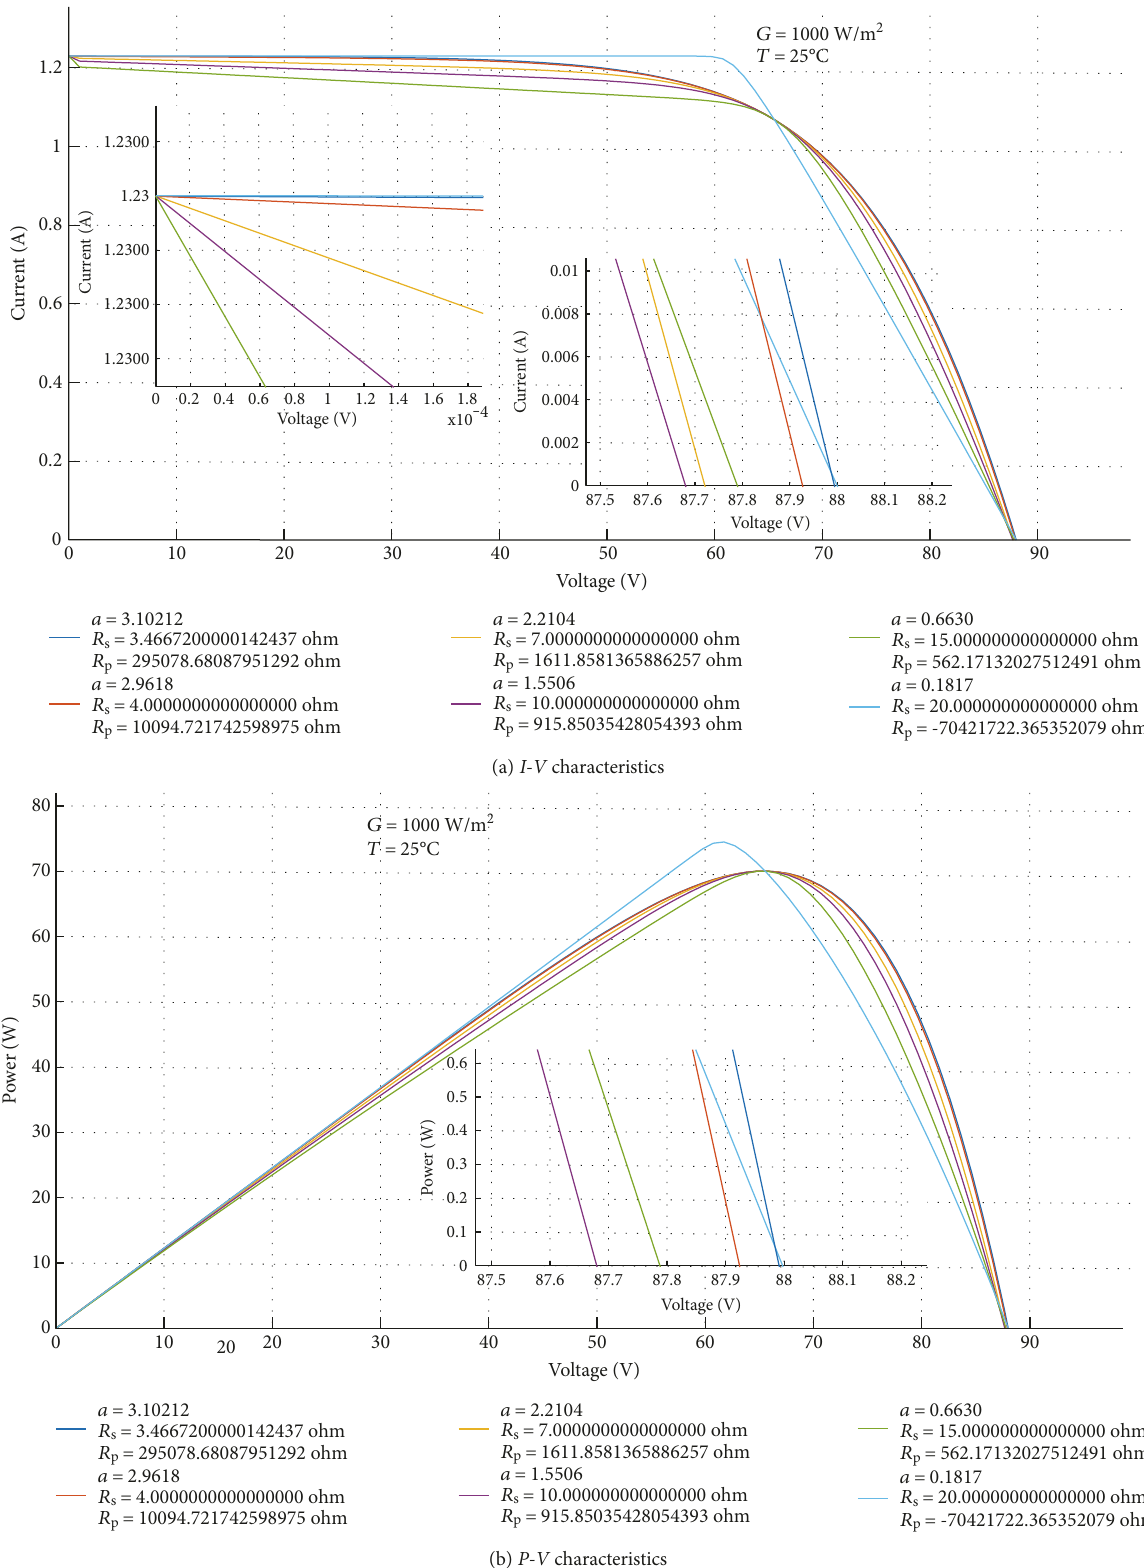
Figure 4: Characteristics for six values of R 1000W/m 2